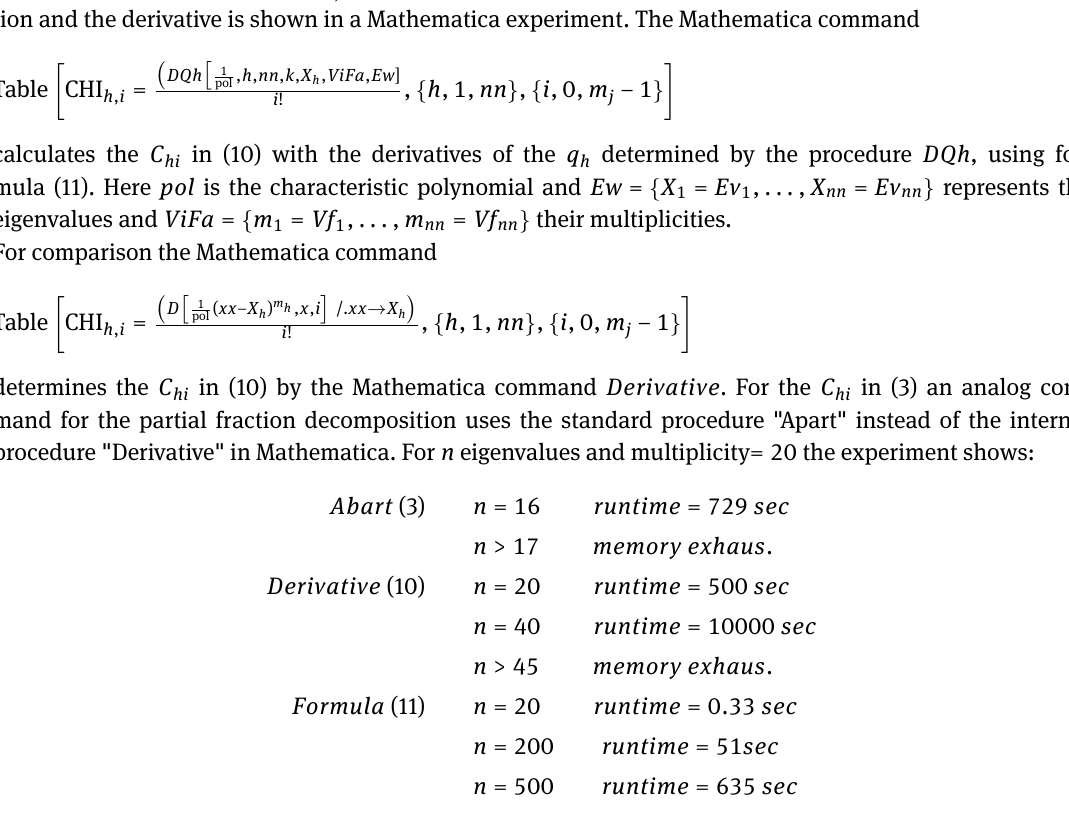
(cid:0) (cid:2) 1 DQh pol , h , nn , k , X h , ViFa , Ew ]